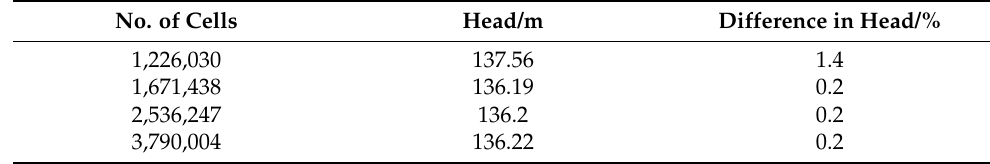
Figure 2. Computational domain model and grid of pump. Table 2. Mesh independence verification test.